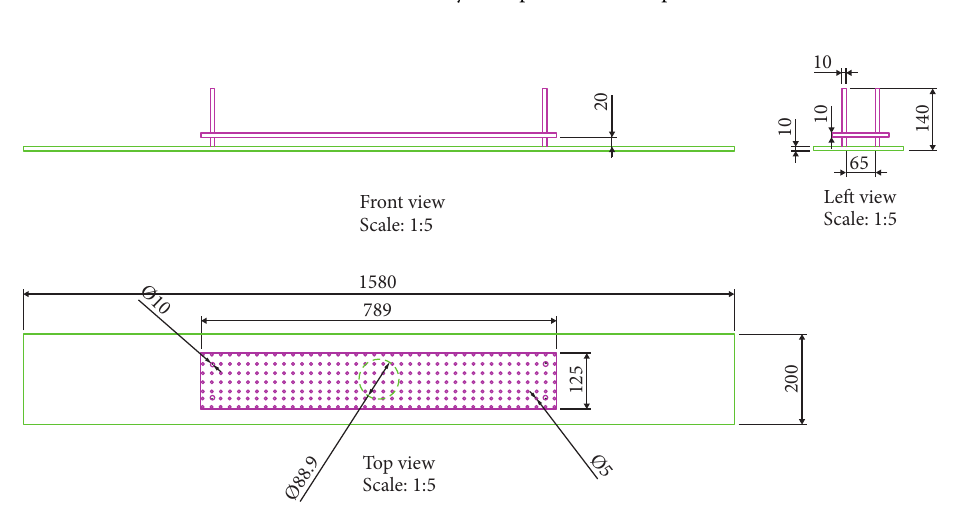
Figure 7: Design of the jet breaker